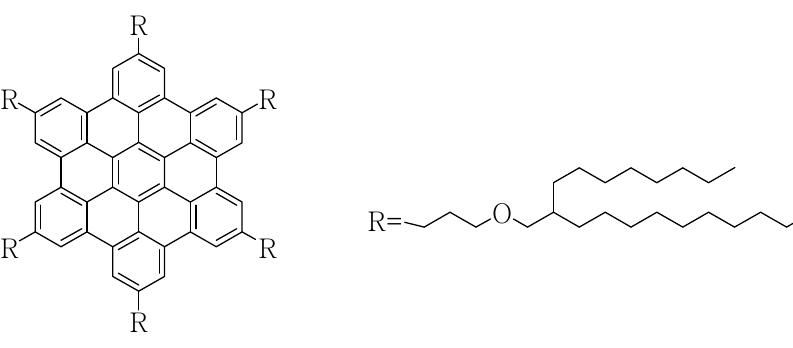
Figiure 1. Structre of the synthesized HBC